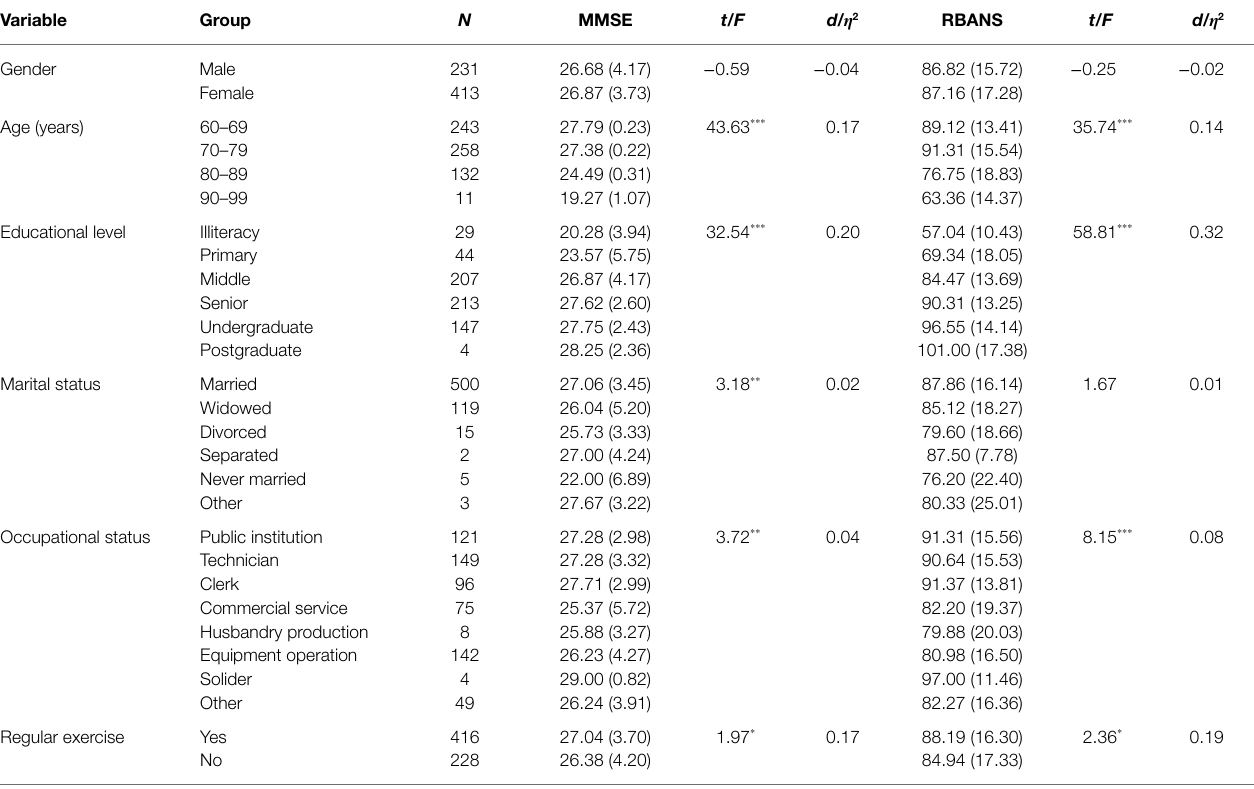
TABLE 2 | Univariate analysis for factors of cognitive function among older adults in urban China. Variable Group